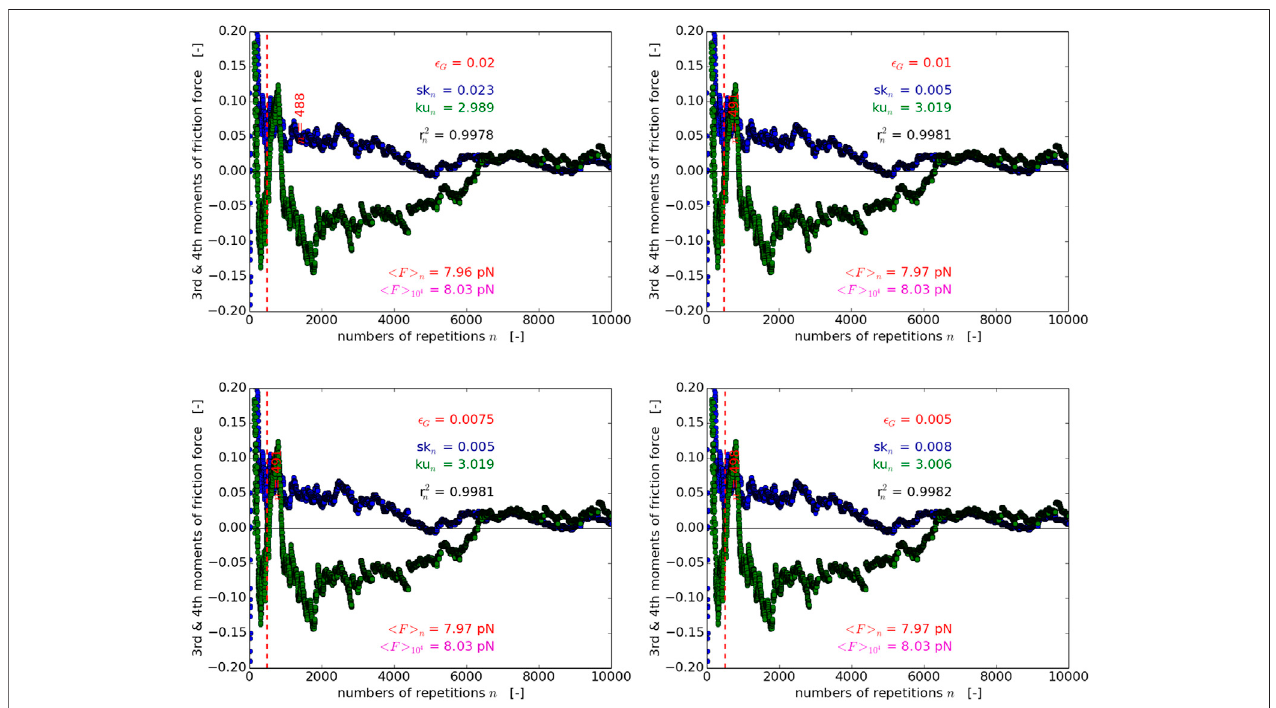
FIGURE 5 | Convergence of the friction force skewness (blue) and kurtosis (green) within the 1D PT-model, together with the number n of repetitions needed (red dashed line)toachieveagivenaccuracy ε G ,andtothisaccuracycorrespondingPearson ’ slinearcorrelationcoef fi cient r 2 n .Inaddition,themeanofthefrictionforce 〈 F 〉 n is compared with the reference mean 〈 F 〉 10 4 obtained by repeating 10 4 times one and the same numerical